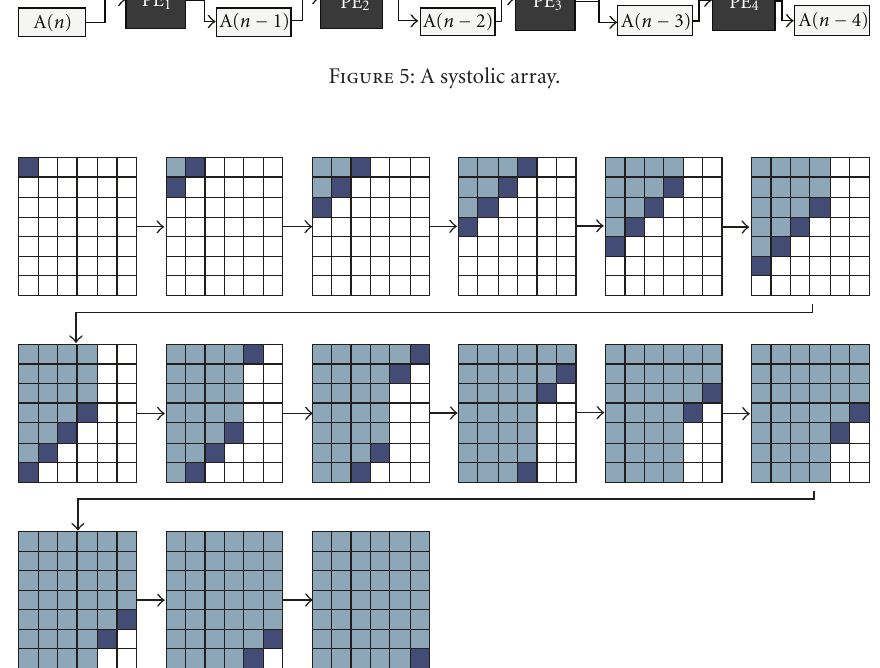
Figure 6: Progress of the PEs in the score matrix during the Smith-Waterman algorithm [20].